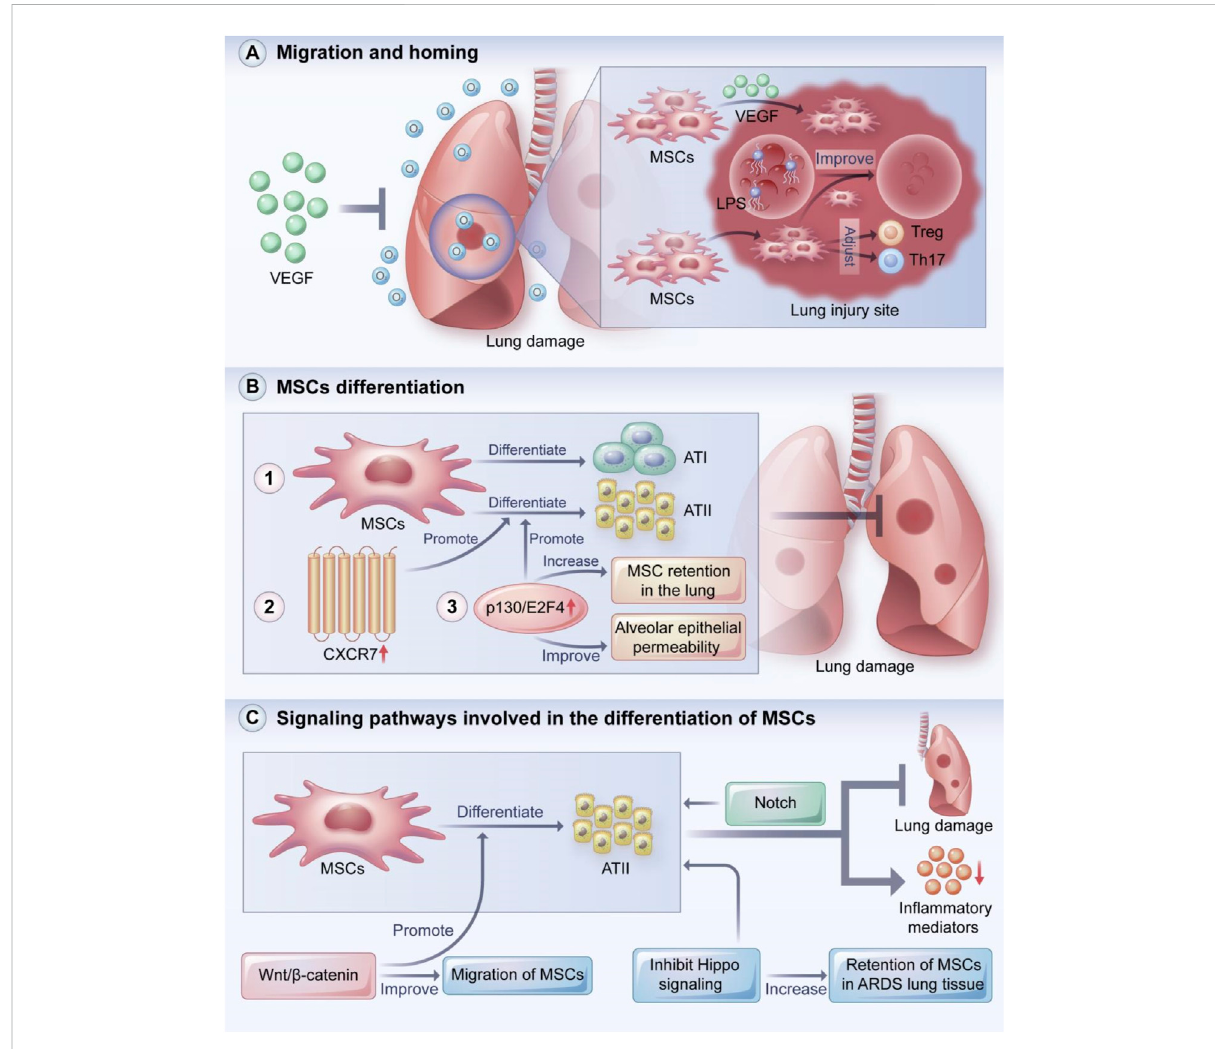
FIGURE 2 MSCs migration and homing, MSCs differentiation and signaling pathways involved in the differentiation of MSCs. VEGF plays a key role in recruiting MSCs to damaged tissues, thereby preventing hyperoxia-induced lung injury. In addition, MSCs can migrate and remain at the injury site, regulatethebalanceofTreg andTh17cells, andameliorateLPS-induced lunginjury. MSCscanprotectthelungfrom injurybylocalizingtodamaged lung tissue and directionally differentiating into ATI and ATII cells. Overexpression of CXCR7 promotes differentiation of MSCs to ATII cells, and overexpression of p130/E2F4 enhances differentiation of MSCs to ATII cells and increases retention of MSCs in the lung and improves alveolar epithelialpermeability.Wnt/ β -catenin,HippoandNotchsignaling pathwaysplayimportantrolesinthedifferentiation,migrationandtissueretention of MSCs. VEGF: vascular endothelia growth factor; Treg: regulatory T cells; ATI: type I alveolar epithelial cells; ATII: type II alveolar epithelial cells. (A) MSCs migration and homing, (B) MSCs differentiation and (C) signaling pathways involved in the differentiation of